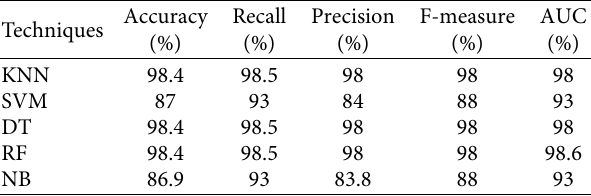
Table 5: Result of ML for selected features by LDA.